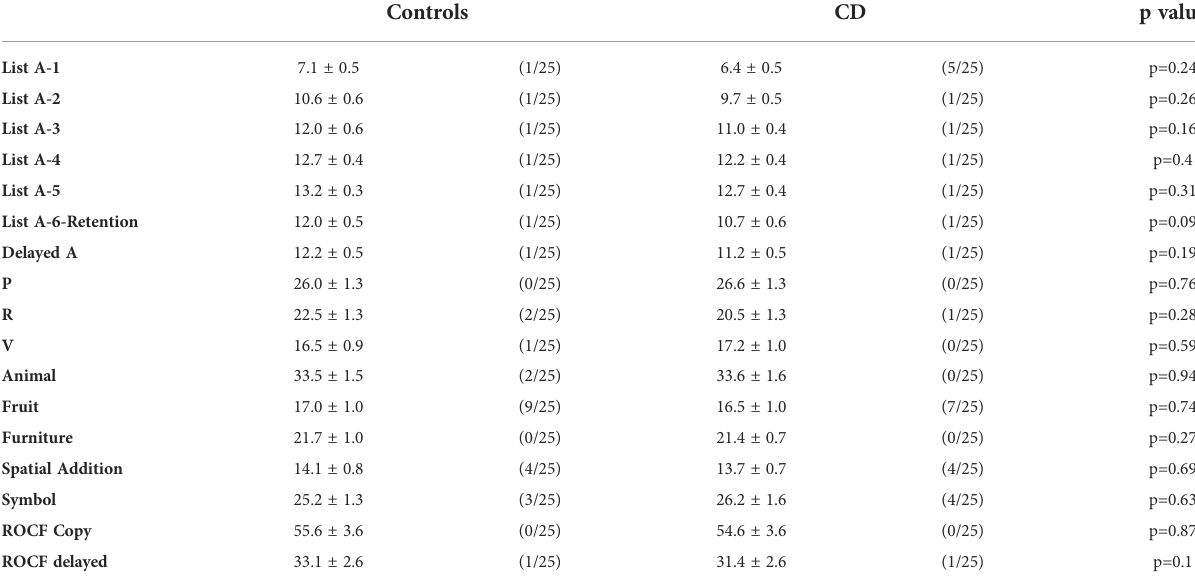
TABLE 2 Mean responses during various cognitive